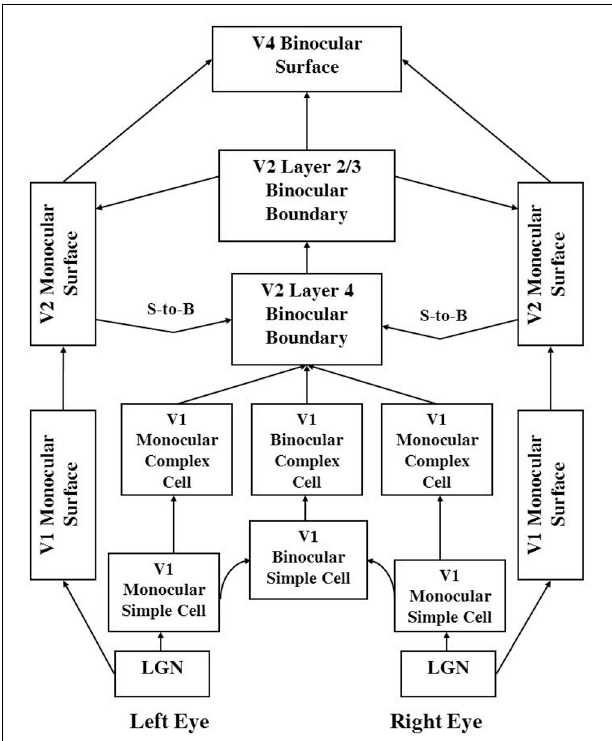
FIGURE 2 | 3D LAMINART functional macrocircuit. This figure provides functional names of the processes that are shown in Figure 1 . In order to clarify which functional name corresponds to which mathematical variables and anatomical processing stages in Figure 1 , the connections in this figure are drawn to mimmick those in Figure 1 . The abbreviation S-to-B stands for Surface-to-Boundary feedback signals. These functional names are used to define the mathematical variables in Section 4. They are also used to label the processing stages in the simulation Figures 6 – 10 . Taken together, Figure 1 , and this figure and Section 4 should enable the reader to track each variable that was simulated, as well as the mathematical equation that determines its dynamics through time.